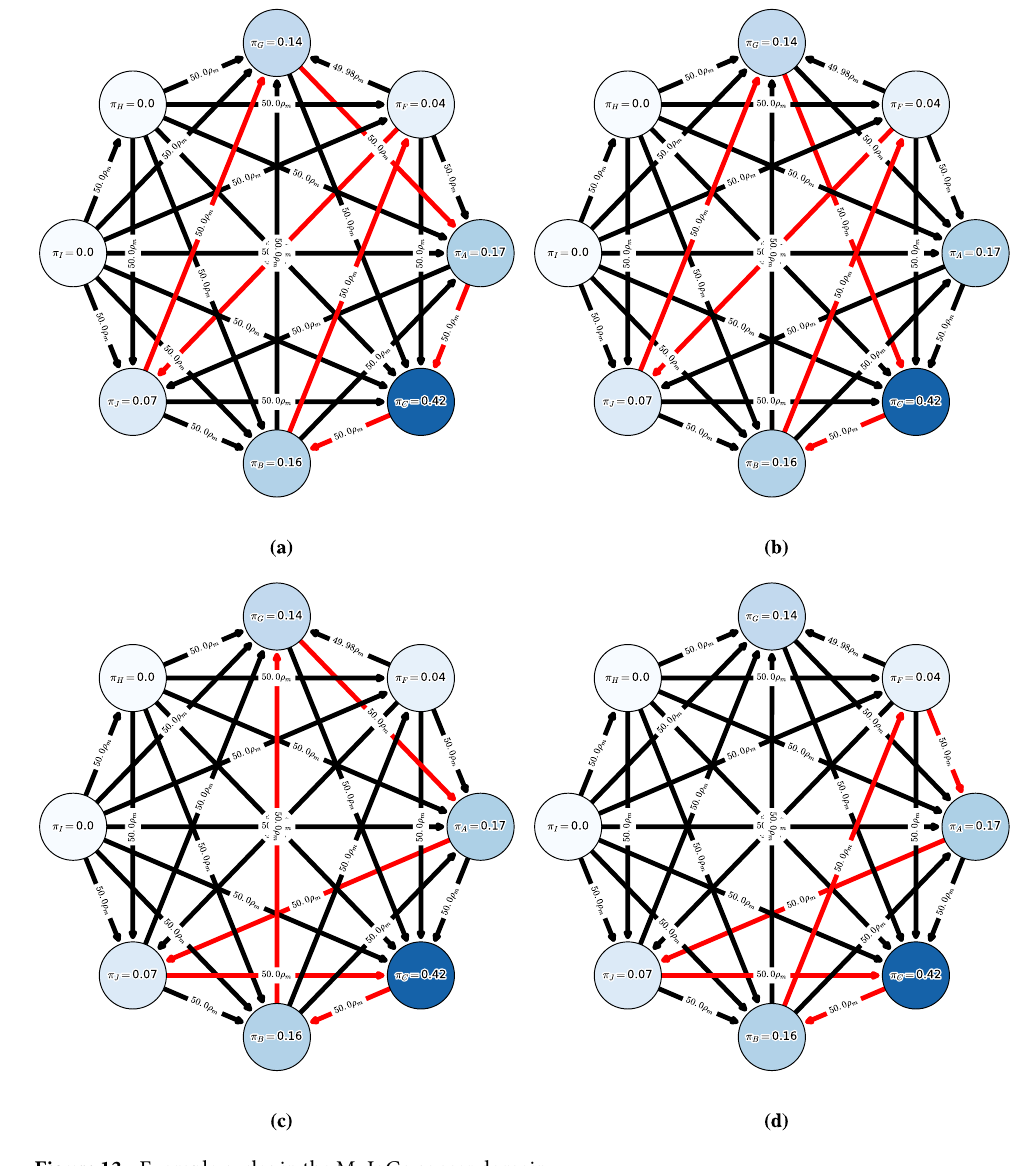
Figure 13. Example cycles in the MuJoCo soccer